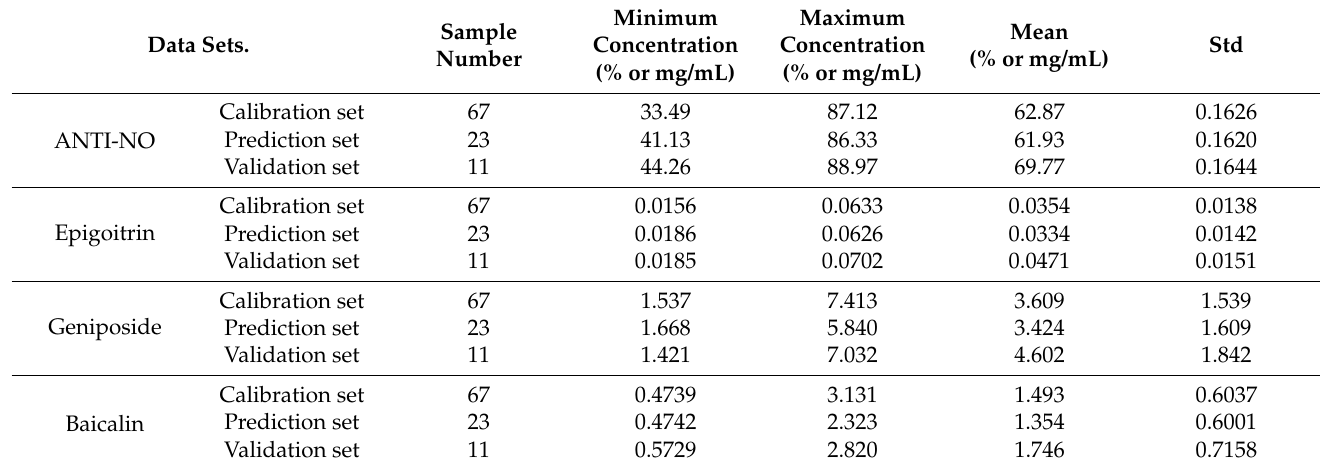
Table 1. Reference values for 4 indexes in the data sets.